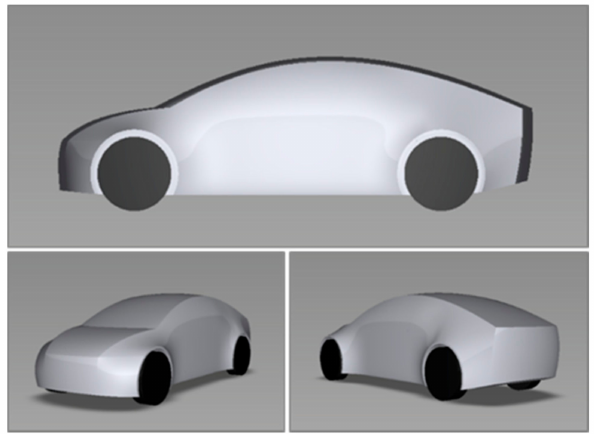
Figure 1. Full-scale Resnick concept model design, after [50] © SAE International